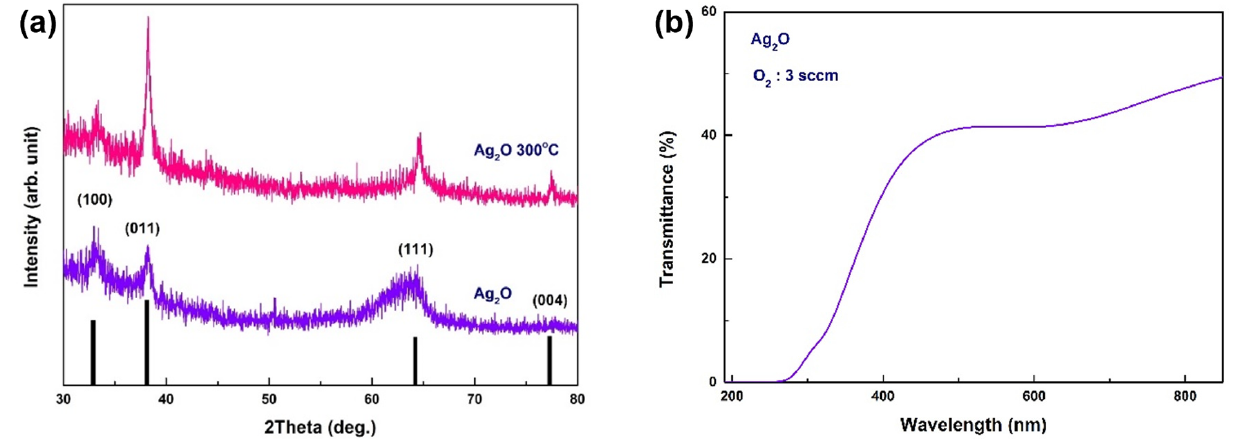
Figure 5. Characteristics of p-type Ag 2 O thin film. ( a ) XRD pattern of Ag 2 O thin film. ( b ) Transmit- tance of Ag 2 O thin